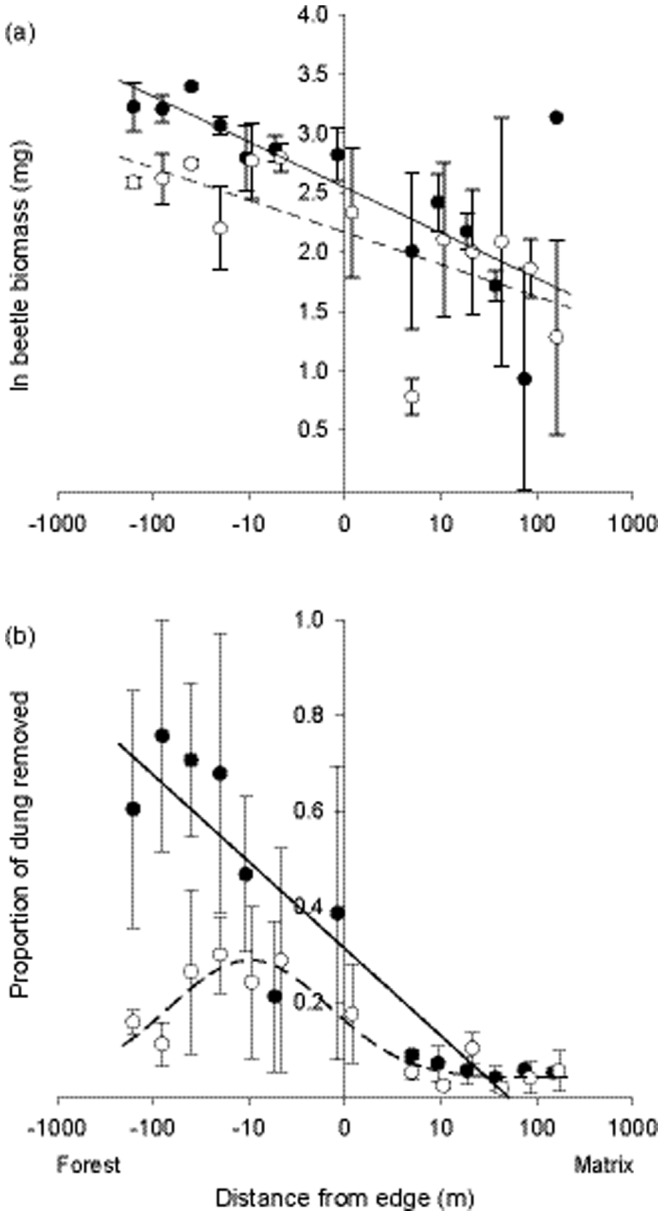
Variation in total beetle biomass and proportion of dung removed across degraded and regenerating edges.Points and error bars are mean ±1 SE. Open symbols and dashed fitted lines denote degraded edges, whereas closed symbols and solid fitted lines denote regenerating edge gradients. Negative values on the x-axis indicate forest sites. Lines are the best-fit continuous edge response functions of five fitted models of increasing complexity. Both model fits in (a) are linear, while the model fit for regenerating edges in (b) is linear and for degraded edges in (b) is unimodal (see Appendix S3). Overlapping points are offset for clarity.